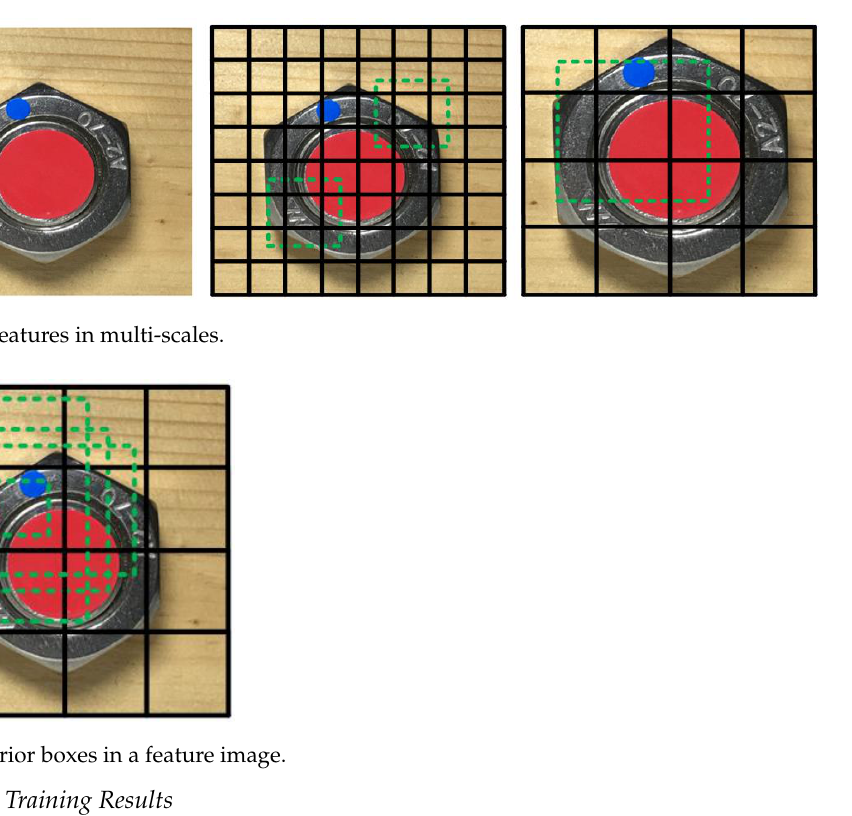
Figure 7. Prior boxes in a feature image.